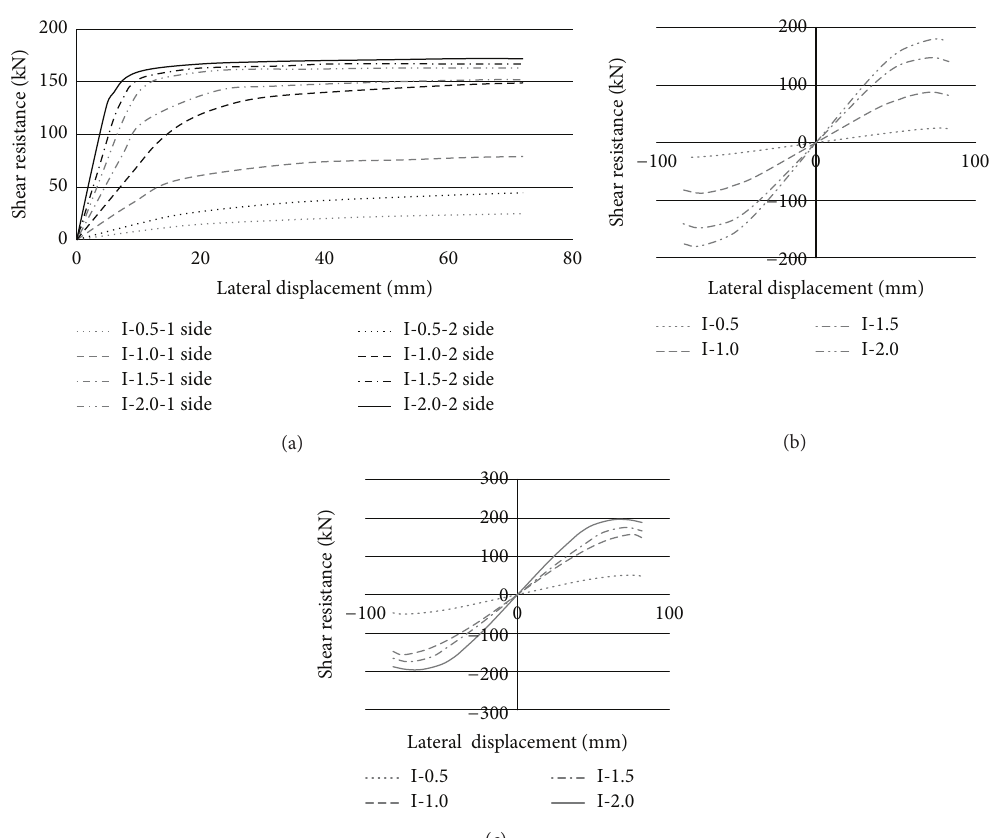
loading of these specimens with lateral and bilateral braces, and 83.02% and 99.74%, respectively, under cyclic